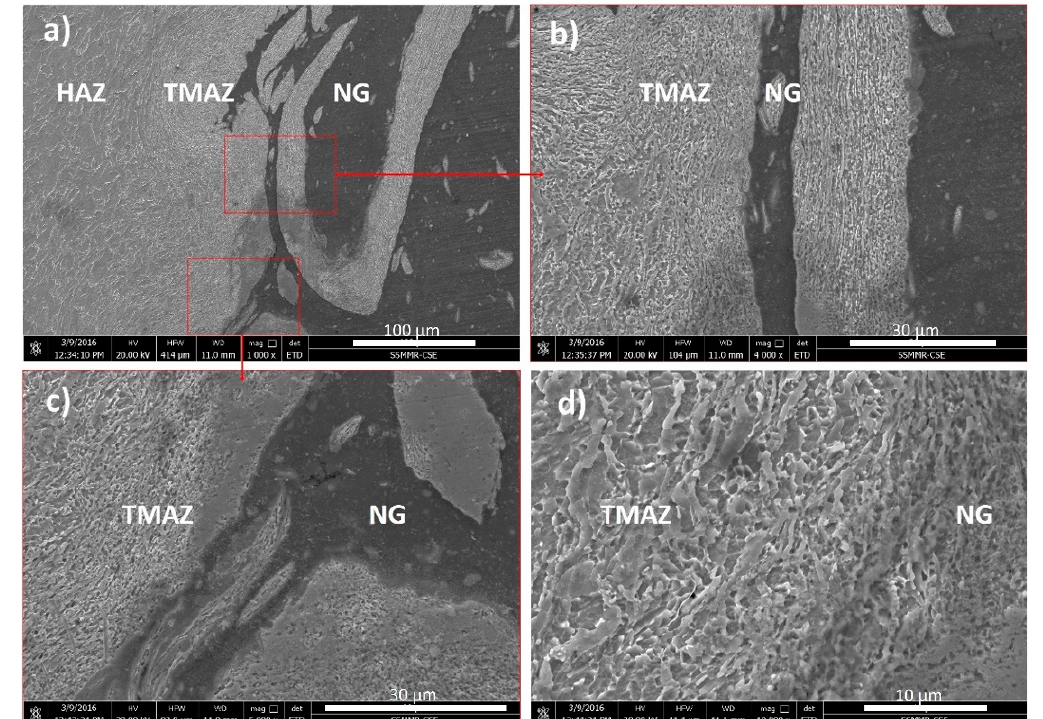
Figure 7. SEM micrographs for the FSWed joint produced at 250 rpm and 25 mm/min showing different magnifications at the interface between Al and steel in ( a – c ); ( d ) at the interface between the thermo-mechanically affected zone (TMAZ) and nugget (NG). The different zones are indicated on the micrographs: Heat affected zone (HAZ), TMAZ and NG.